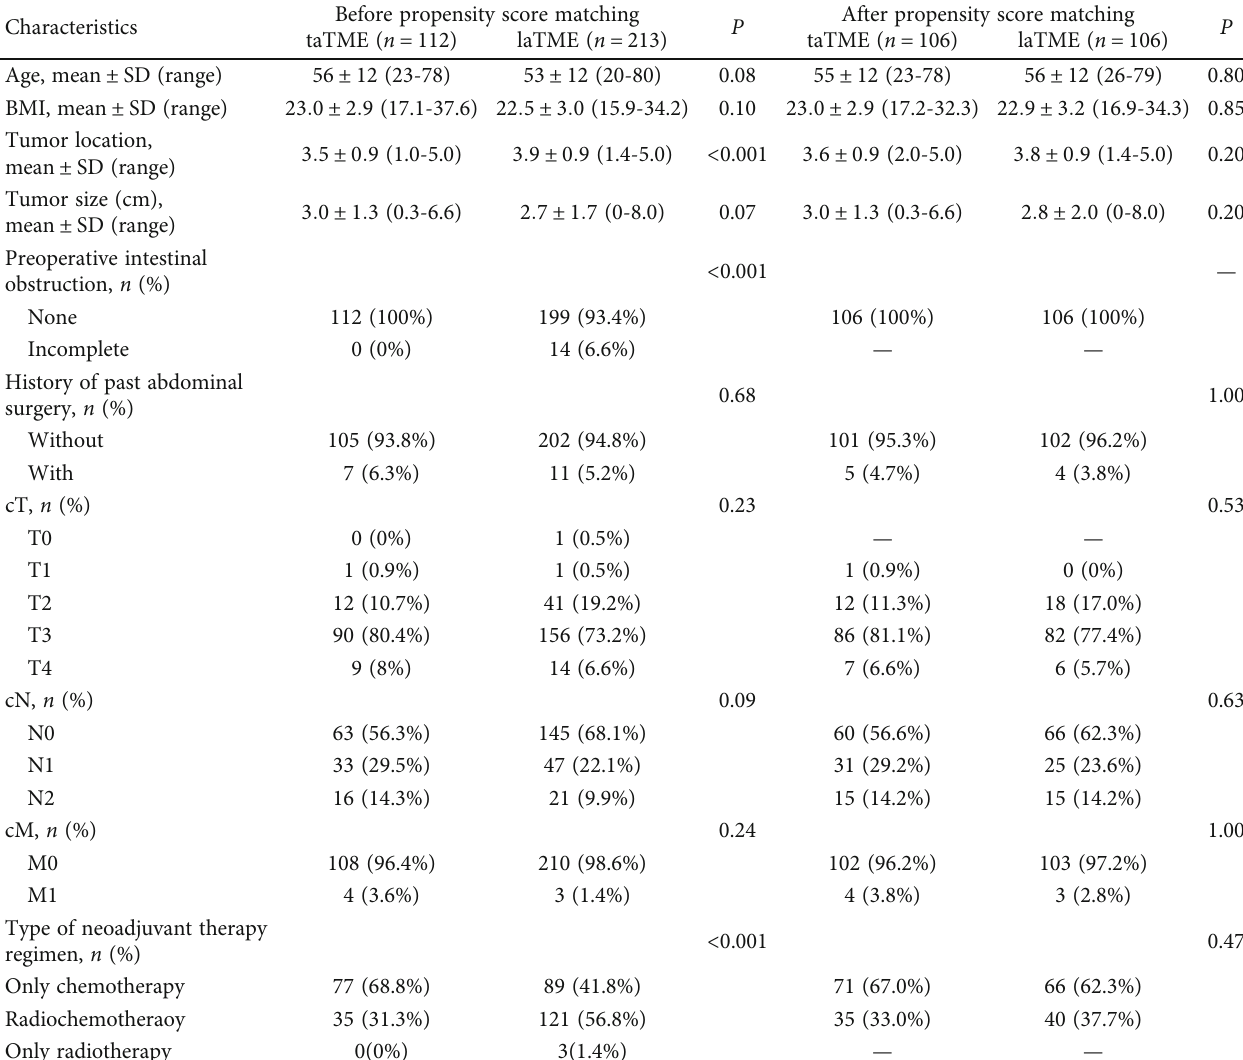
Table 1: Demographic and clinical data before and after propensity score